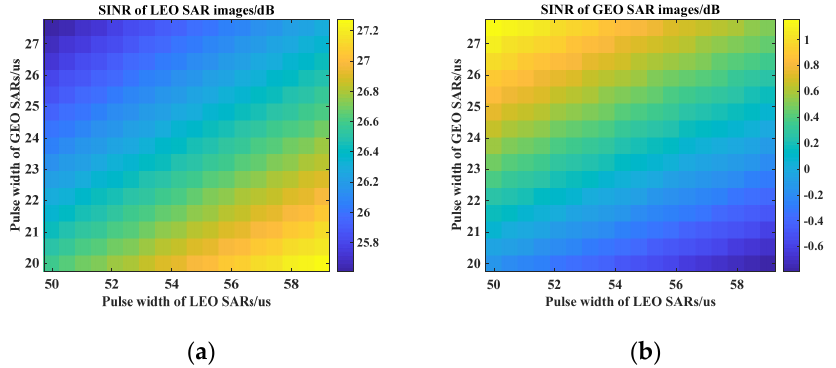
Figure 7. The relationship between bandwidth and SINR of LEO SARs and GEO SARs images in the presence of scattered wave RFI ( σ B = σ 0 ). The red line indicates that the LEO SAR has the same bandwidth as the GEO SAR, and the invalid value in the yellow box indicates the LEO SAR has the same FM rate as the GEO SAR; ( a ) the integration time is 0.5 s; ( b ) the integration time is 220 s.